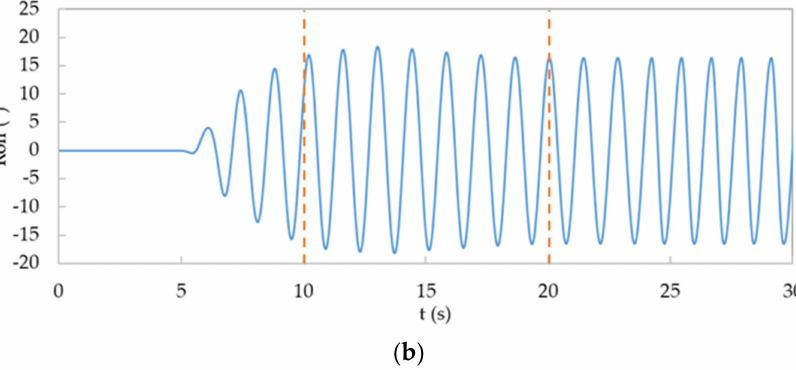
Figure 10. Time histories of the ship’s motion in the numerical simulations. Vertical dashed lines: markers that indicate the start of transition stage using medium mesh B and the correction stage using fine mesh C. ( a ) Heave motion; ( b ) Roll motion.